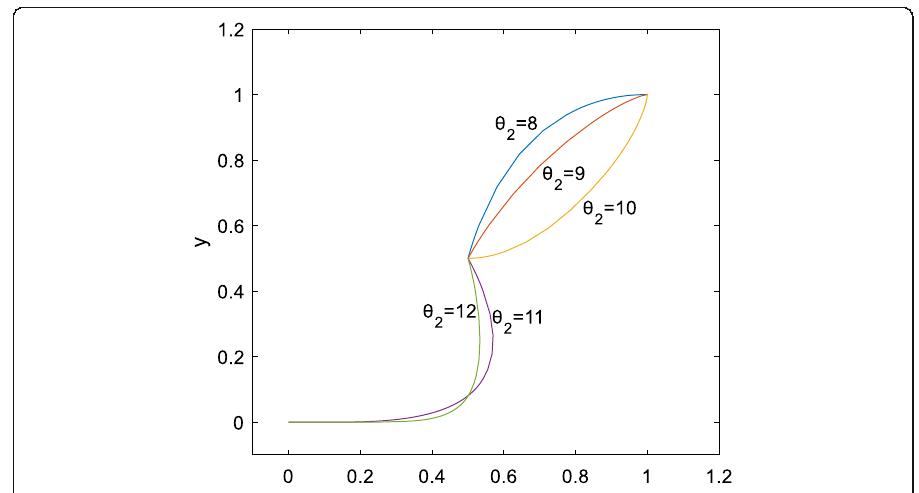
Fig. 10 Evolutionary game of the system with different costs . Source: Authors ’ processing using Matlab